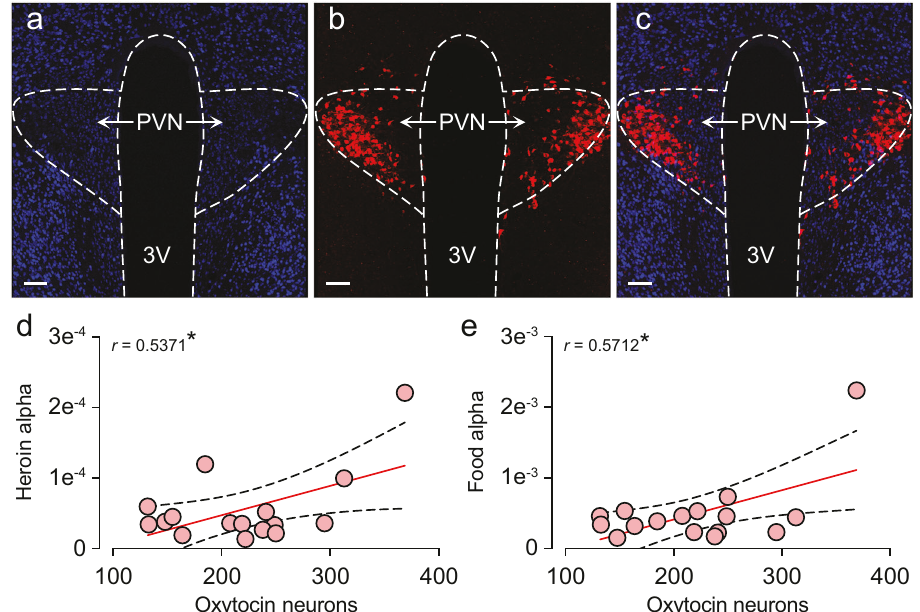
Fig. 6 The number of oxytocin neurons in the paraventricular hypothalamus correlates with both heroin and food demand elasticity. a Representative images of the hypothalamus (DAPI), b oxytocin immuno fl uorescence, and c the overlay showing the anatomical boundaries for the paraventricular hypothalamus (PVN). 3V third ventricle. Scale bar = 100 µm. The number of PVN oxytocin neurons positively correlated with both heroin α ( d ) and food α ( e ). This pro fi le implicates the oxytocin system as a limiter of motivational states. * p < 0.05 signi fi cant